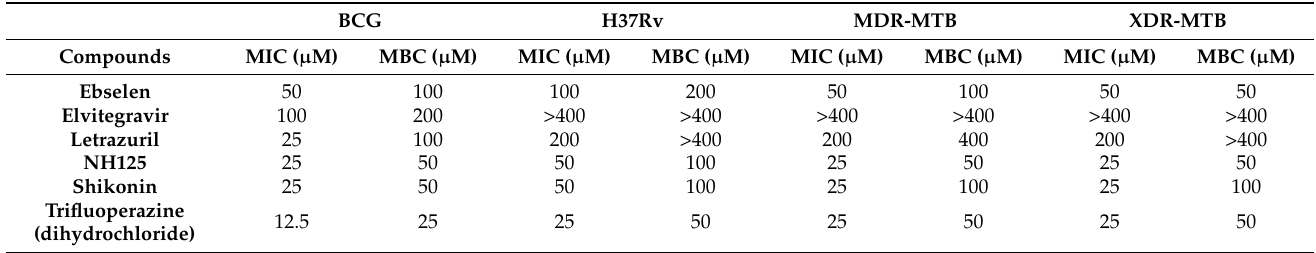
Table 1. The MICs and MBCs of six compounds against BCG and MTB ( n =